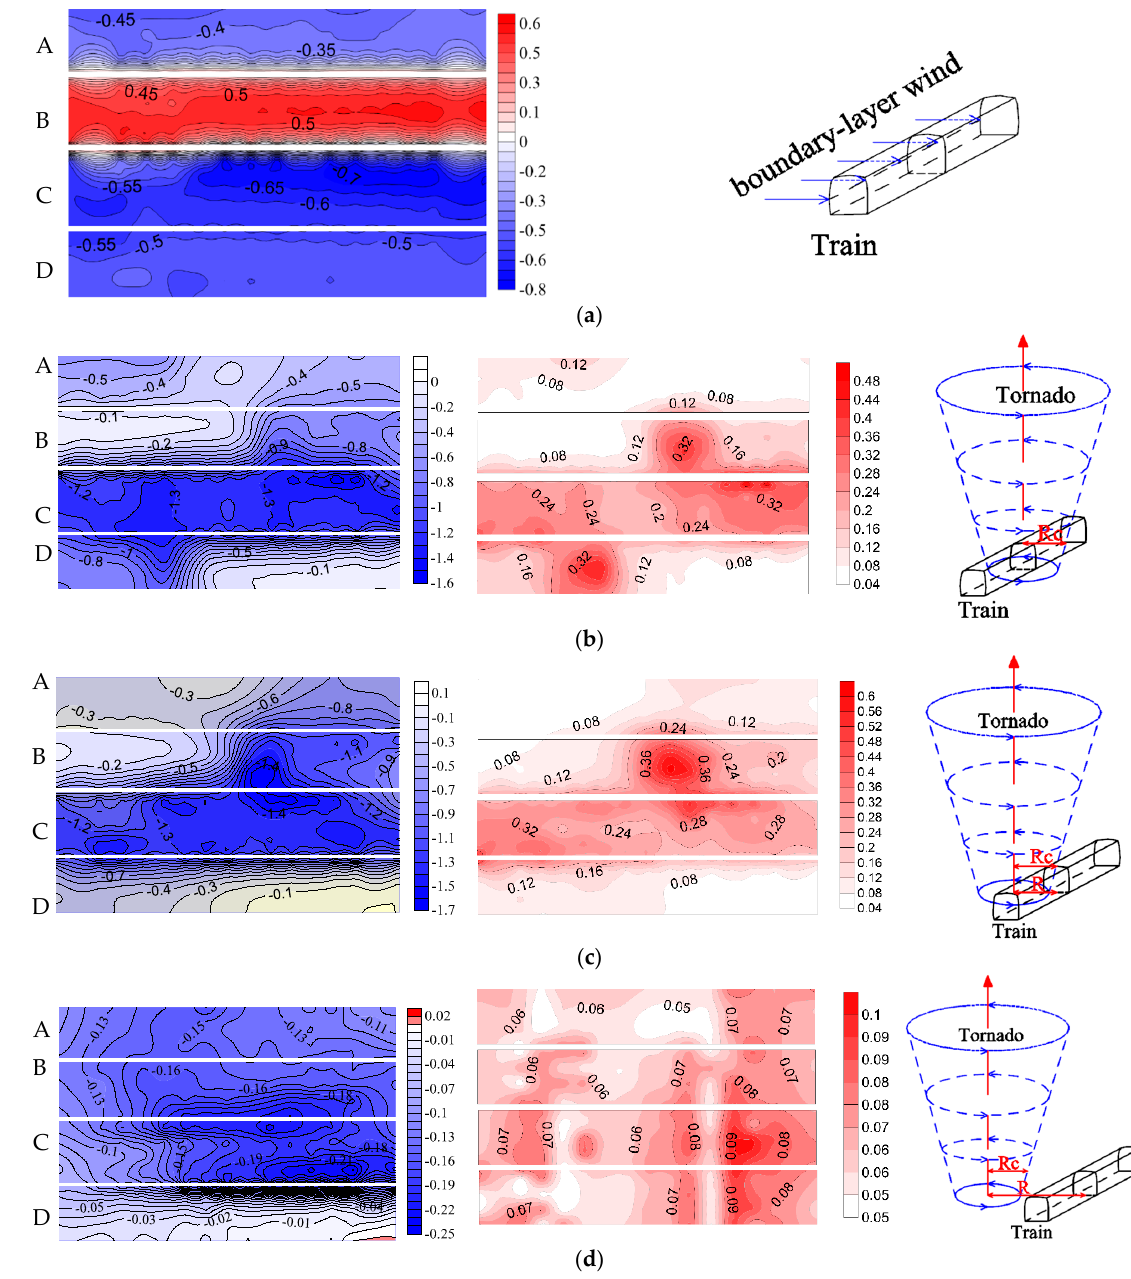
Figure 10. Contours of mean (left sub ‐ figure) and fluctuating (middle sub ‐ figure) pressure coefficient distributions on the car surfaces ( S = 0.35, λ = 0). ( a ) Boundary ‐ layer cross ‐ wind; ( b ) R/R c = 0; ( c ) R/R c = 1; ( d ) R/R c = 3.75. Under the boundary ‐ layer cross ‐ wind conditions, the pressure coefficients of the windward side of the train car were found to be positive (see Figure 10a). The pressure coefficients on the upper and lower surfaces of the train car were negative due to airflow separation. The pressure magnitudes on the lower surface were smaller than those on the upper surface due to the roughness of the ground. The pressure coefficients on the leeward side of the car were negative, and their distribution was relatively smooth compared to those on the other surfaces.